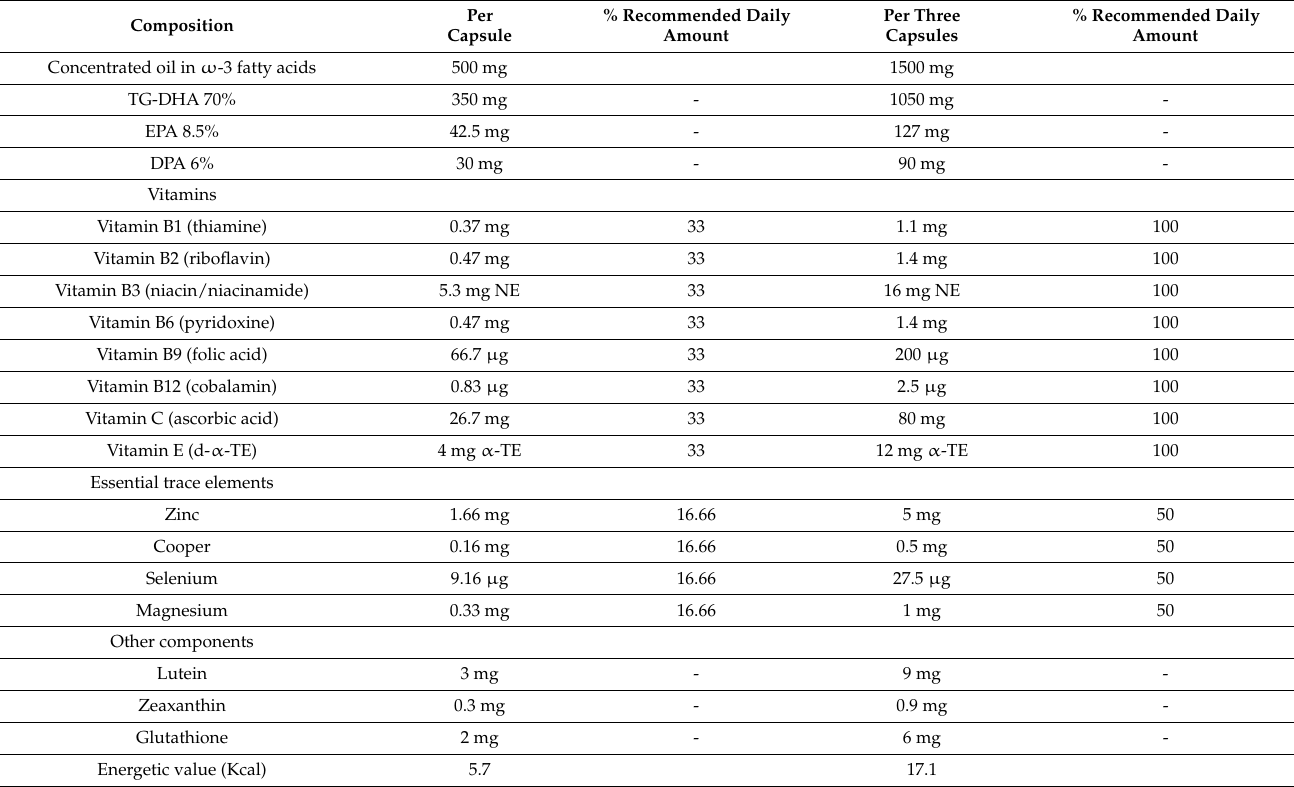
Table 1. Composition of Brudyretina 1.5 g per